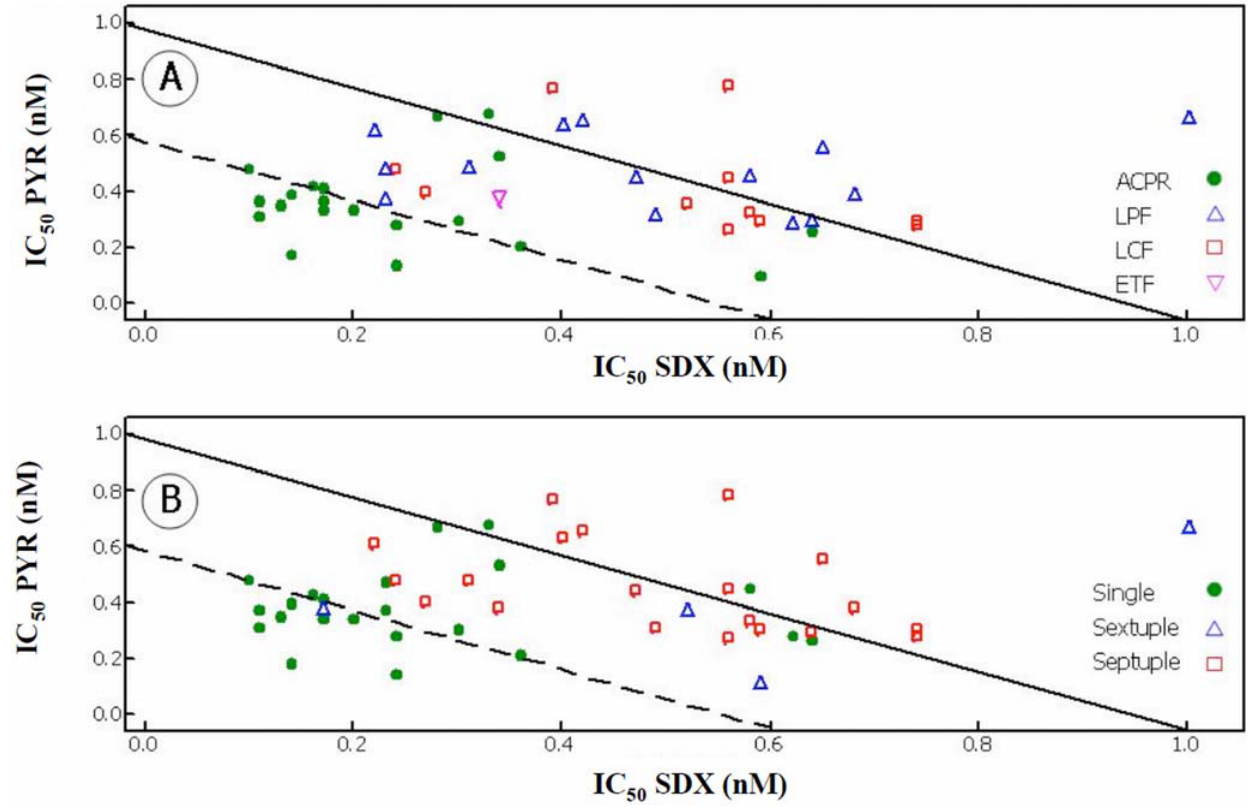
Figure 3. The derived isobolograms for the interaction of SDX and PYR and how they related to treatment outcome (Panel A: ACPR N , LPF D , LCF % , ETF , ) and genotypes (Panel B: single N , sextuplet D , septuplet % ). FIC , 0.59 (dashed line) was classified as synergy; 0.6–1.5 was classified as additive (solid line) and . 1.5 was classified as antagonism.